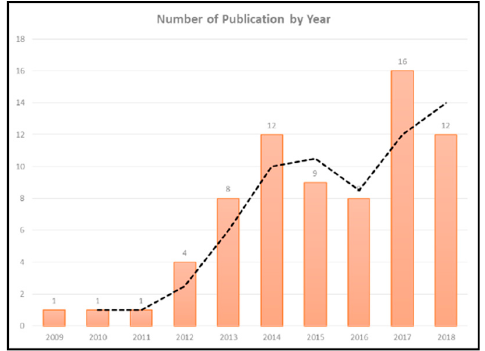
Figure 2. Publication years (duration). Table 4. Collected articles from different online databases.